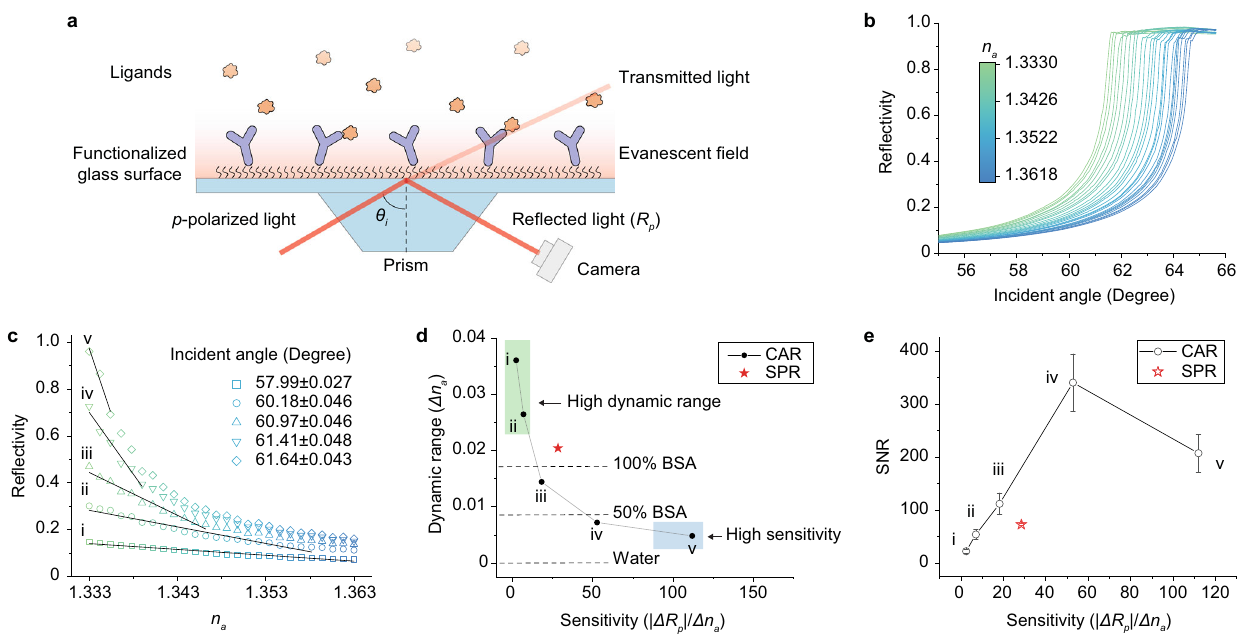
Fig. 1 Detection principle of CAR. a Experimental setup and surface chemistry. A protein functionalized cover glass is placed on a prism-coupled SPR imaging setup with index-matching oil. The incident angle θ i of a p -polarized light is set at slightly below the critical angle. Upon ligands binding to the proteins, the intensity of the re fl ected light changes and is detected by a camera. b Measured re fl ectivity change as a function of incident angle. The refractive index ( n a ) on the surface is adjusted by serially adding ethanol to water to make n a range from 1.3330 (pure water) to 1.3630 (50% ethanol in water). c Measured re fl ectivity as a function of n a at fi ve representative incident angles (labeled with i to v) with data obtained from b . The solid lines show the linear regions (de fi ned by R 2 > 0.97, where R 2 is the coef fi cient of determination) of the curves. d Tunable sensitivity and dynamic range of CAR. The black dots show the sensitivity and dynamic range determined at the fi ve representative angles in c , where the sensitivity and dynamic range are the slope and the range of the linear regions, respectively. The red star marks the sensitivity and dynamic range of SPR, which is not adjustable. To facilitate comparison, the refractive index change induced by the binding of a full layer of BSA (100% BSA), half layer of BSA (50% BSA), and pure water (water) are marked by the dashed lines. The green and blue shadows mark the regions where CAR has high dynamic range and high sensitivity, respectively. e Measured signal-to-noise ratio (SNR) of SPR and CAR at the fi ve representative angles. Noise is de fi ned as 1 minute of root mean square of baseline signal. The dots and error bars represent the mean and standard deviation of three